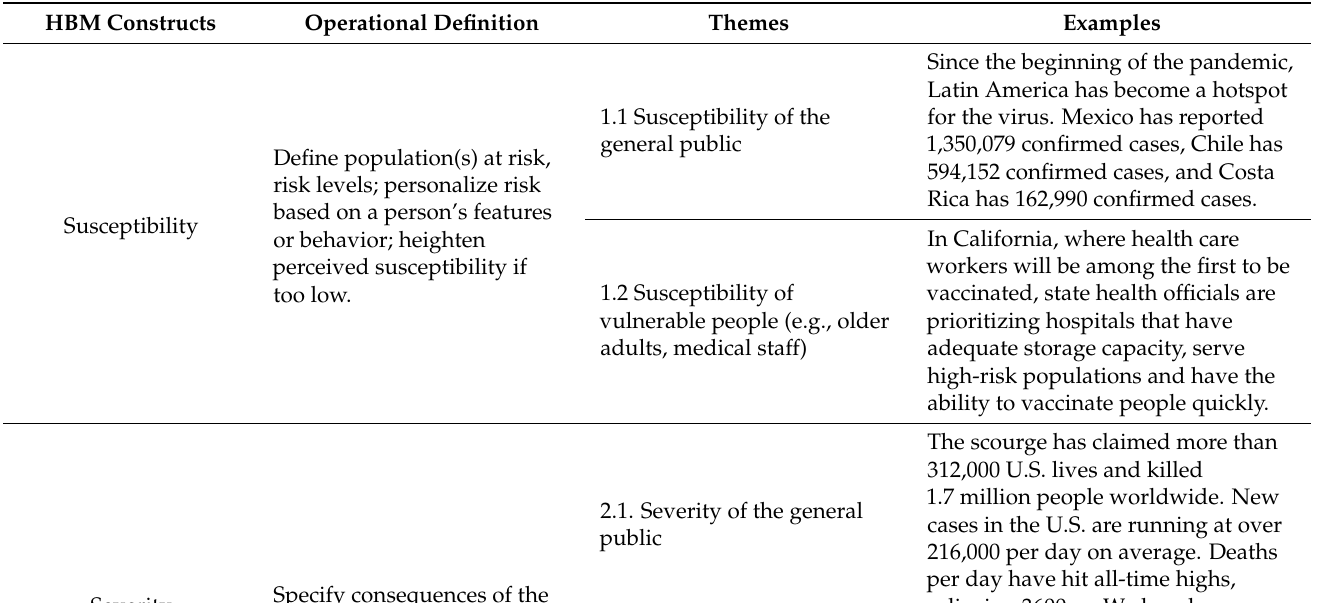
Table 1. Operational definitions and